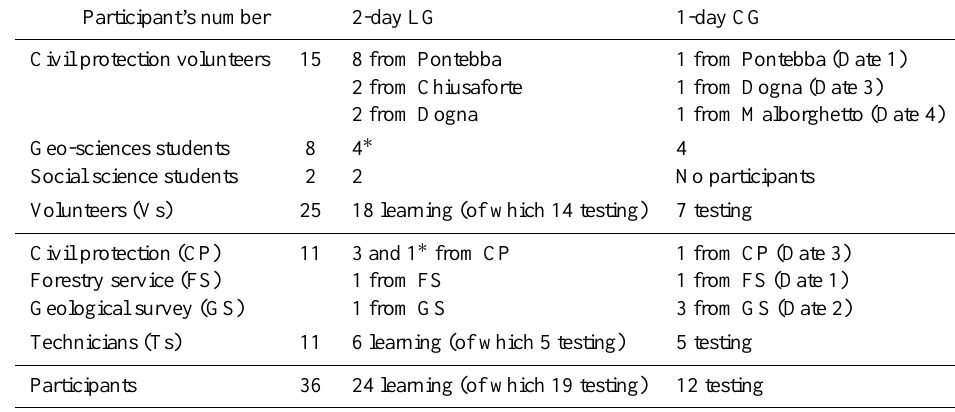
Table 1. Participants’ distribution between learning groups (LGs) and control groups